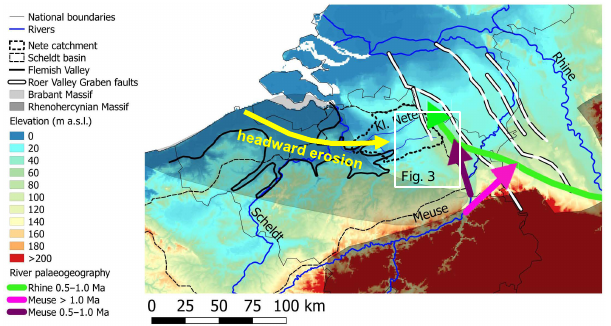
Figure 2. Structural map of northwestern Europe showing the Roer Valley graben faults and the Brabant and Rhenohercy- nian (Ardennes) massifs superimposed on a digital terrain model (DTM; GTOPO30; data available from the U.S. Geological Survey), with indication of large rivers (http://www.eea.europa. eu/data-and-maps/data/wise-large-rivers-and-large-lakes) and lo- cation of the Scheldt Basin, (dashed line), the Nete catchment (dot- ted line) and the Flemish Valley (solid line). The general paleohy- drography of the Meuse and Rhine between 0.5 and 1.0Ma is shown in colored lines. Headward erosion as an explanation for the devel- opment of the Nete catchment is indicated with a yellow arrow.